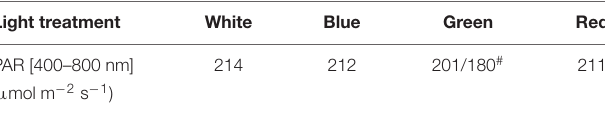
The values represent averages. # Due to the extra green LEDs and the resulting architecture of the light equipment, the UV tube was hanging lower and partly shaded the green lights, thus giving lower PAR in the CA box than in the “Perspex only” box. This shading effect was not happening in the three other light